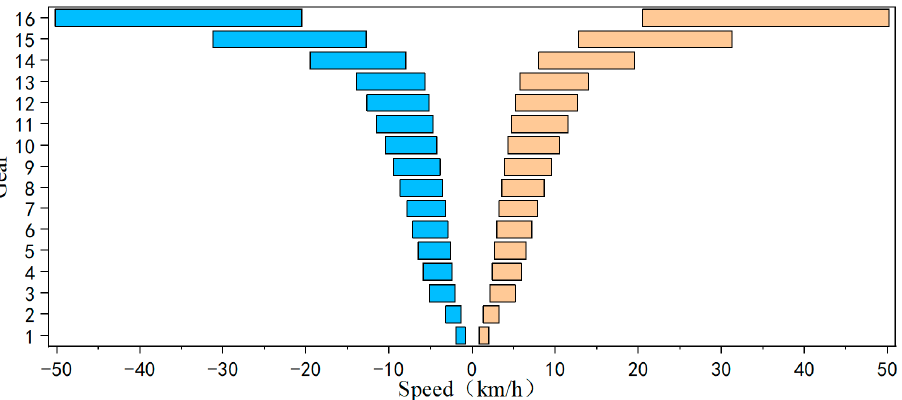
Figure 10. The theoretical driving speed of each gear of the optimized tractor.